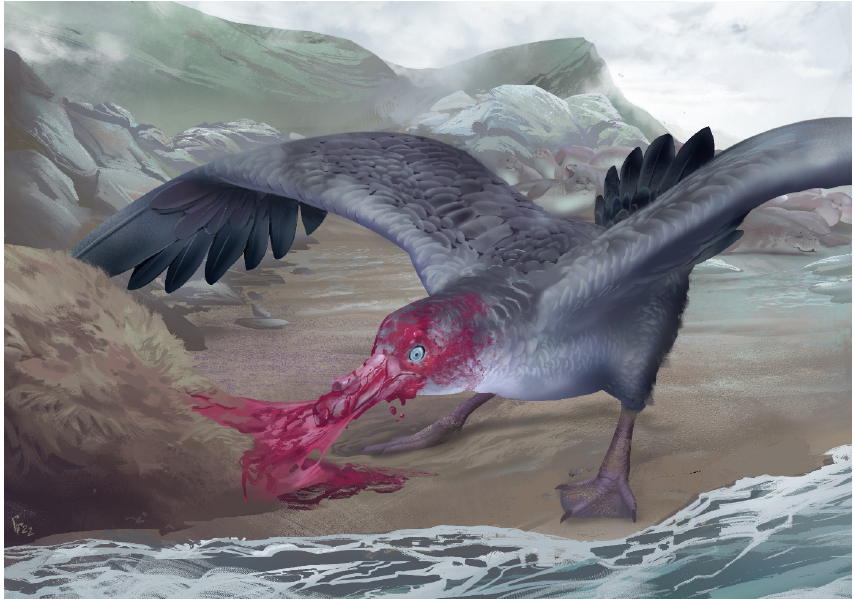
Figure 6. Artistic reconstruction of Macronectes tinae sp. nov. in its palaeoenvironment. Illustration by Simone Giovanardi, © Te Papa (CC-BY 4.0). A darker plumage was chosen for the reconstruction because a darker colouration in giant petrels seems to be related to warmer regions [7], as Taranaki had warmer temperatures during the Pliocene [22].